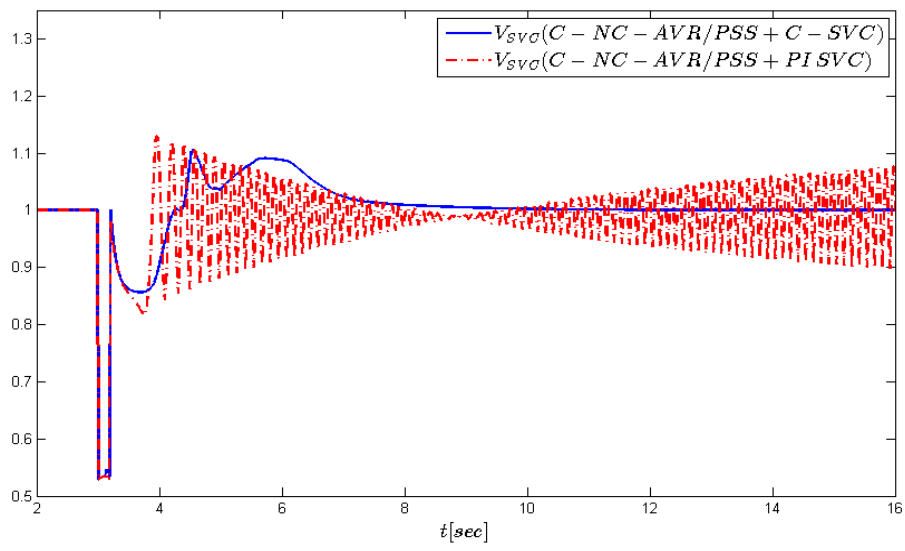
Figure 10. SVC bus voltage responses (in p.u.).